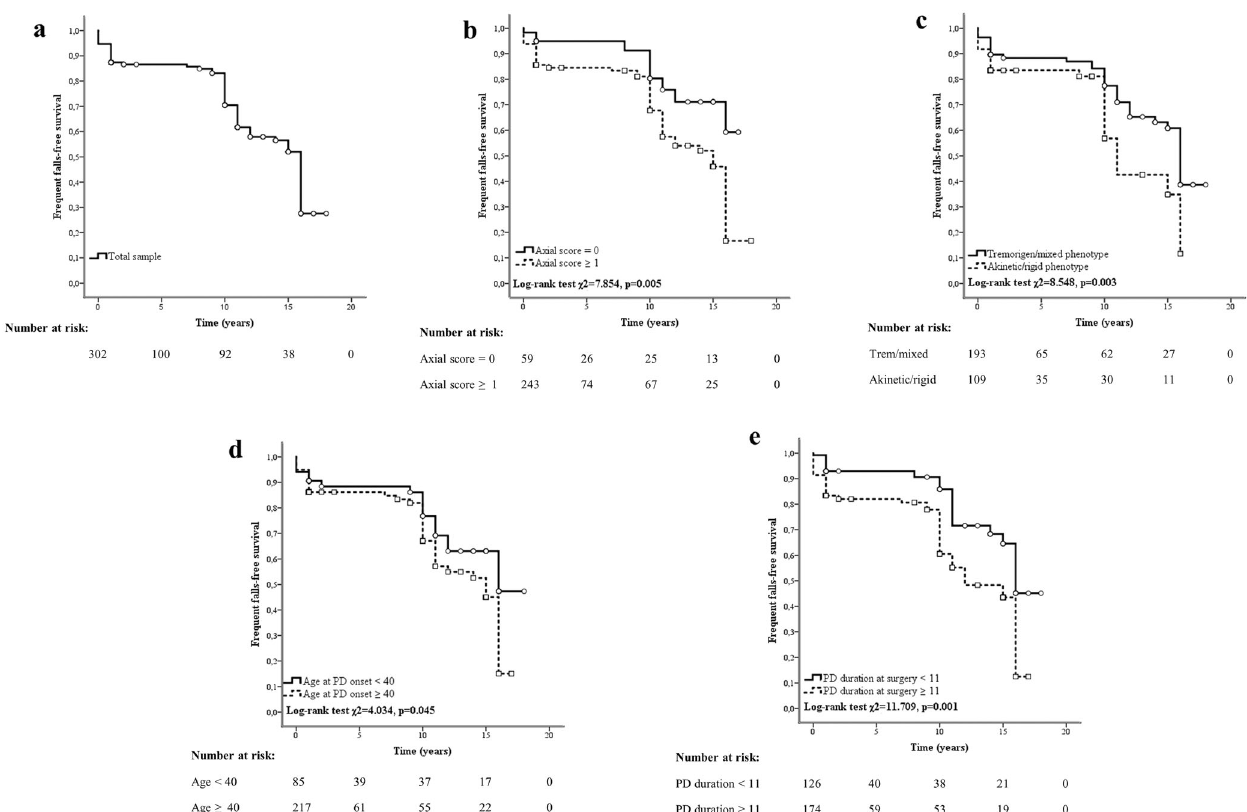
Fig. 3 Risk factors for frequent falls in people with Parkinson ’ s disease and subthalamic deep brain stimulation. Kaplan – Meier curves show the occurrence of frequent falls in the total sample ( a ) and subgroups of people with Parkinson ’ s disease (PD) and subthalamic deep brain stimulation based on preoperative axial scores ( b ), clinical phenotype ( c ), age at disease onset ( d ), and disease duration at surgery ( e ). The “ frequent falls-free survival ” re fl ects the occurrence of frequent falls based on item 13 of the Uni fi ed Parkinson ’ s Disease Rating Scale part II ≥ 2. Squares and circles in the Kaplan – Meier curves indicate censored